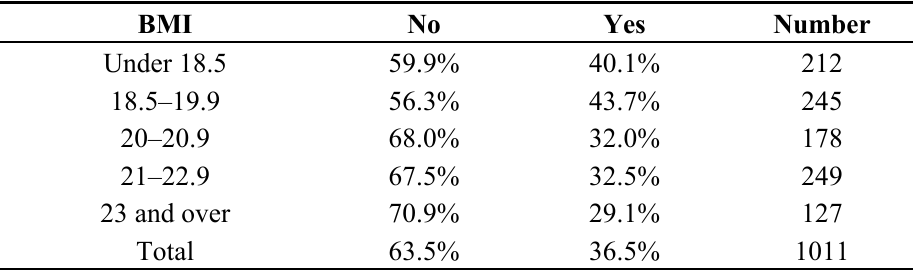
Table 2. Prevalence of Nausea by Body Mass Index